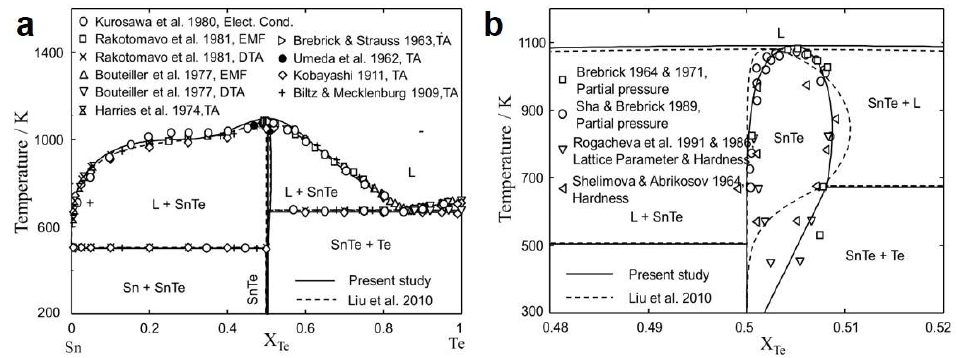
Figure 3. ( a ) Calculated phase diagram of Sn-Te system along with experimental data and ( b ) enlarged homogeneity range of SnTe compound along with experimental data from